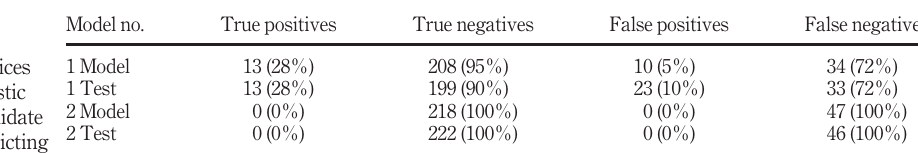
Table VII. Candidate models for predicting the likelihood of a contract experiencing an